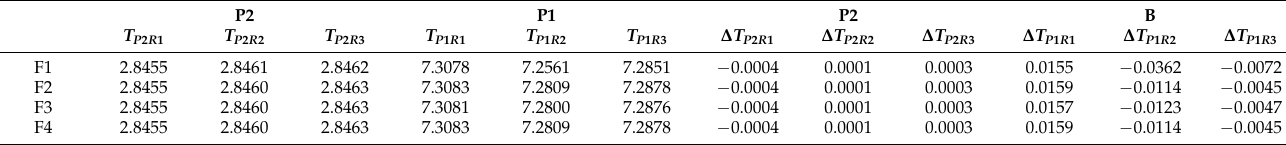
Table 7. Comparison of the calculated periods T based on the four different functions and for the three runs R1, R2 and R3—the presented differences represents the values minus the average over all three runs of the period based on F2-all values in Seconds.